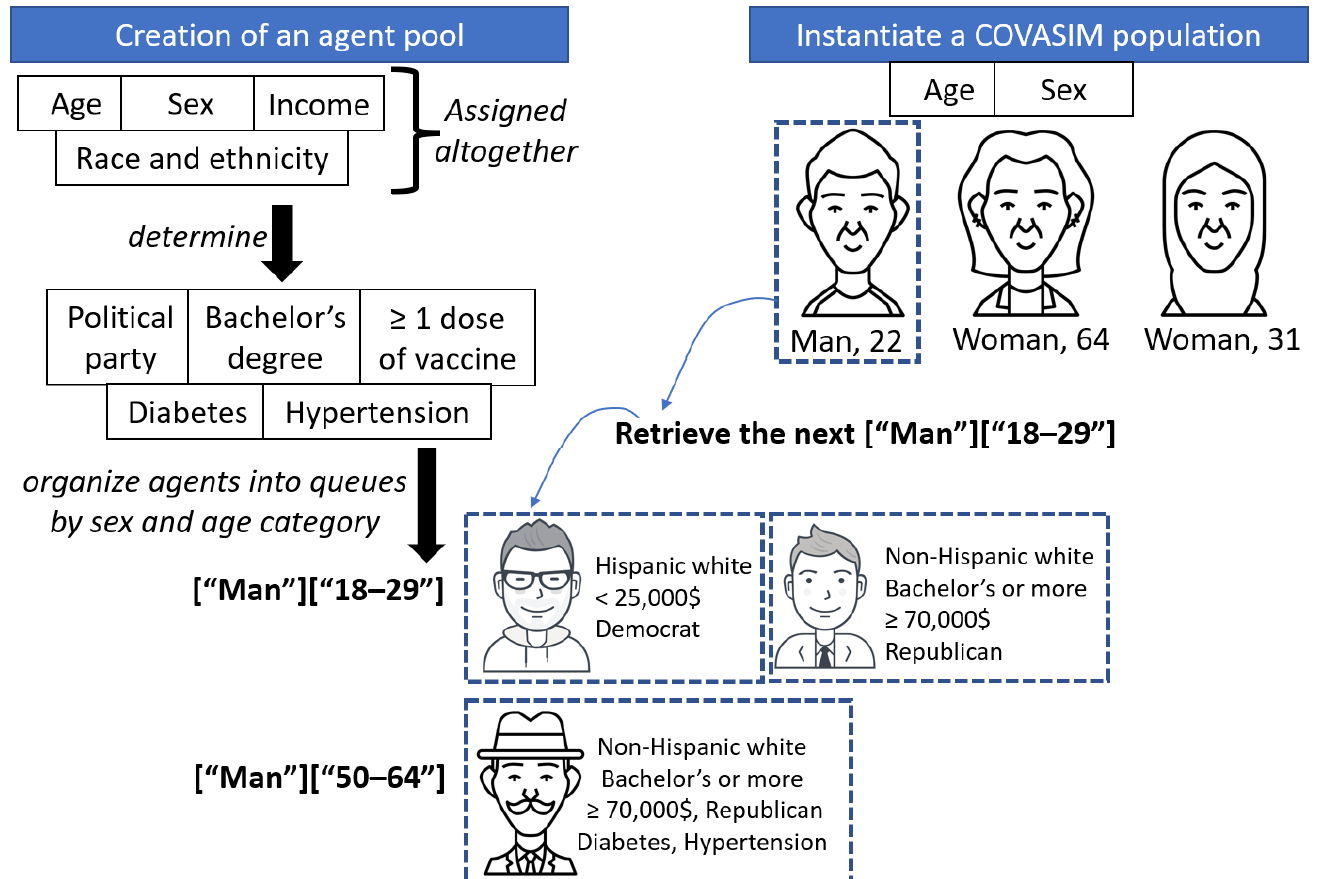
Figure 2. The attributes of COVASIM agents can be expanded by matching them with virtual individuals from a large pool generated from nationally representative U.S. datasets (Table 3). The pool should be larger than the COVASIM population to ensure that each retrieval request for a matching profile can be satisfied. Icons from User Insights and Domp Icon at icon-icons.com, CC Attribution license (CC BY 4.0).